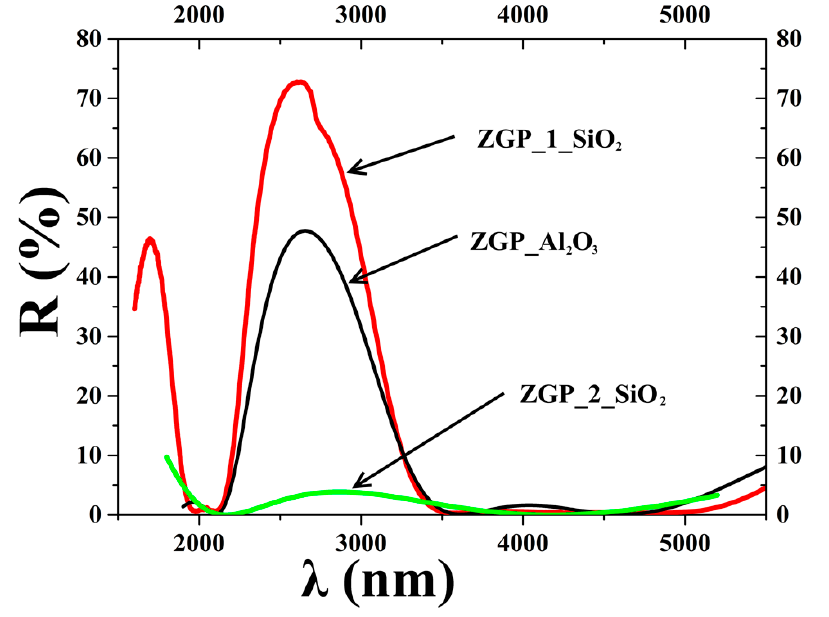
Figure 4. Reflection spectra of working faces of samples ZGP_Al 2 O 3 , ZGP_1_SiO 2 and ZGP_2_SiO 2 with applied interference coatings.